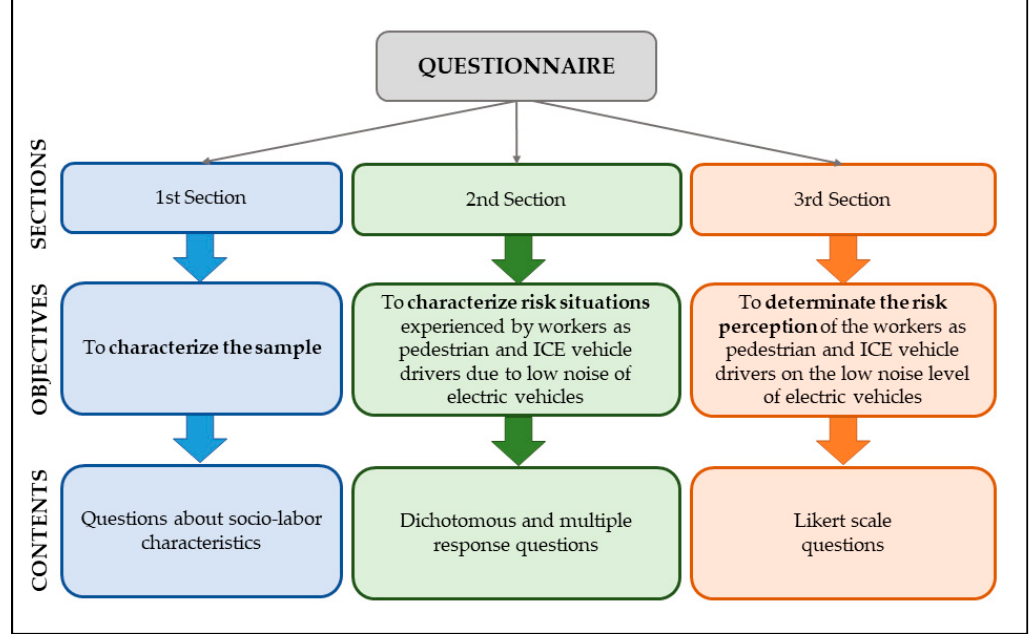
Figure 1. Structure of the questionnaire for workers as pedestrians and internal combustion engine (ICE) vehicle drivers about the situations and risk related to low noise levels of electric vehicles (EVs) and hybrid electric vehicles (HEVs).